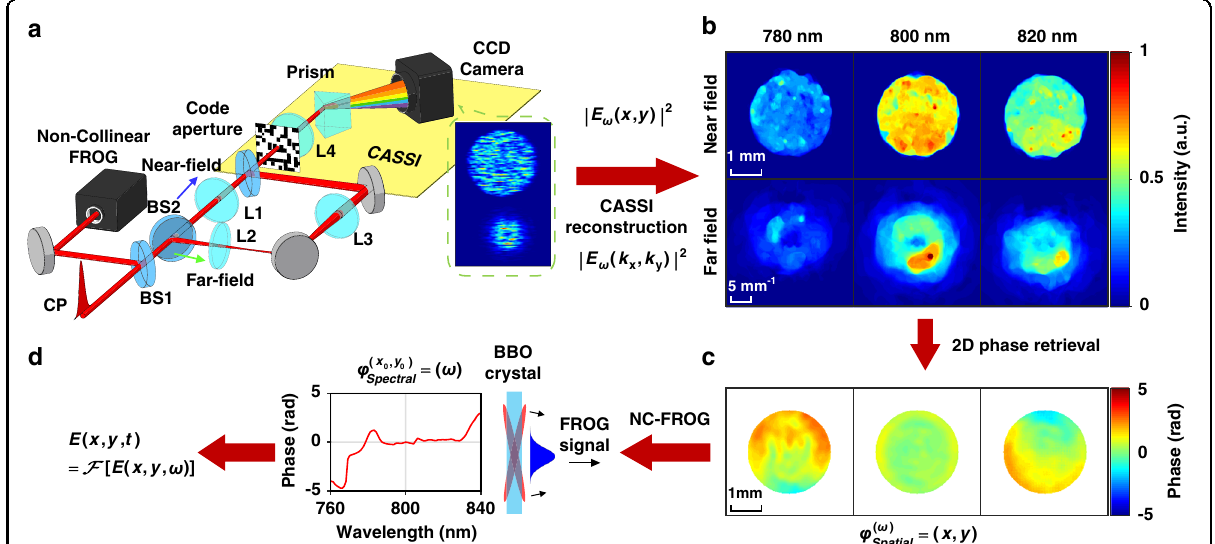
Fig. 1 Principle of COFT based on wavefront recovery and non-collinear FROG. a The experimental setup. An arbitrary optical fi eld at CP, the ω ð Þ checking point, is split by beam splitters (BS1, BS2) into three copies: the fi rst copy goes to the Non-Collinear FROG for spectral phase φ x 0 ; y 0 ð Þ Spectral measurement; the second one is imaged by a lens L1 to the coded aperture; and the third one is focused by L2 to a far- fi eld which is imaged to the coded aperture by L3. The last two copies are spatially off-set and captured by a CASSI system including the coded aperture, a lens L4, a prism, and a camera. Raw data is shown in the inset. b CASSI reconstruction results for the second copy corresponding to the near fi eld intensity distribution (cid:4) (cid:1) (cid:3)(cid:4) (cid:4) (cid:4) 2 (the bottom row), for three wavelengths E ω x ; y ð Þj j 2 (the top row) and the third one corresponding to the far- fi eld intensity distribution E ω k x ; k y at 780 nm (left), 800 nm (middle), 820 nm (right). c Wavefronts [2D spatial phase distributions φ ω ð Þ x ; y ð Þ ] for three spectral components with the Spatial wavelength of 780 nm (left), 800 nm (middle), 820 nm (right), which are retrieved based on corresponding near- and far- fi eld intensity pro fi les shown ð ω Þ reconstructed from the non-collinear FROG trace, with the assistance of 2D optical fi eld information of each spectral in b . d Spectral phase φ x 0 ; y 0 ð Þ Spectral component. The inset schematically shows the principle of non-collinear FROG: two copies of the incident pulse cross each other at a thin nonlinear BBO crystal, and they have a linearly varying temporal delay along the transverse direction, generating transversely distributed sum frequency signal or the FROG